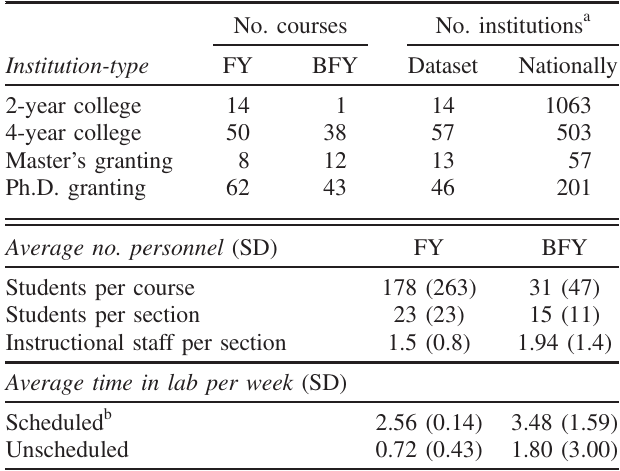
FIG. 1. Average frequency with which students engage in various activities in the lab courses (darker shading means more frequent and values are means (cid:1) standard errors). Instructors could select from never (1), rarely (2), sometimes (3), often (4), or always (5). TABLE I. Summary details about the courses at the first-year and beyond first-year levels included in the